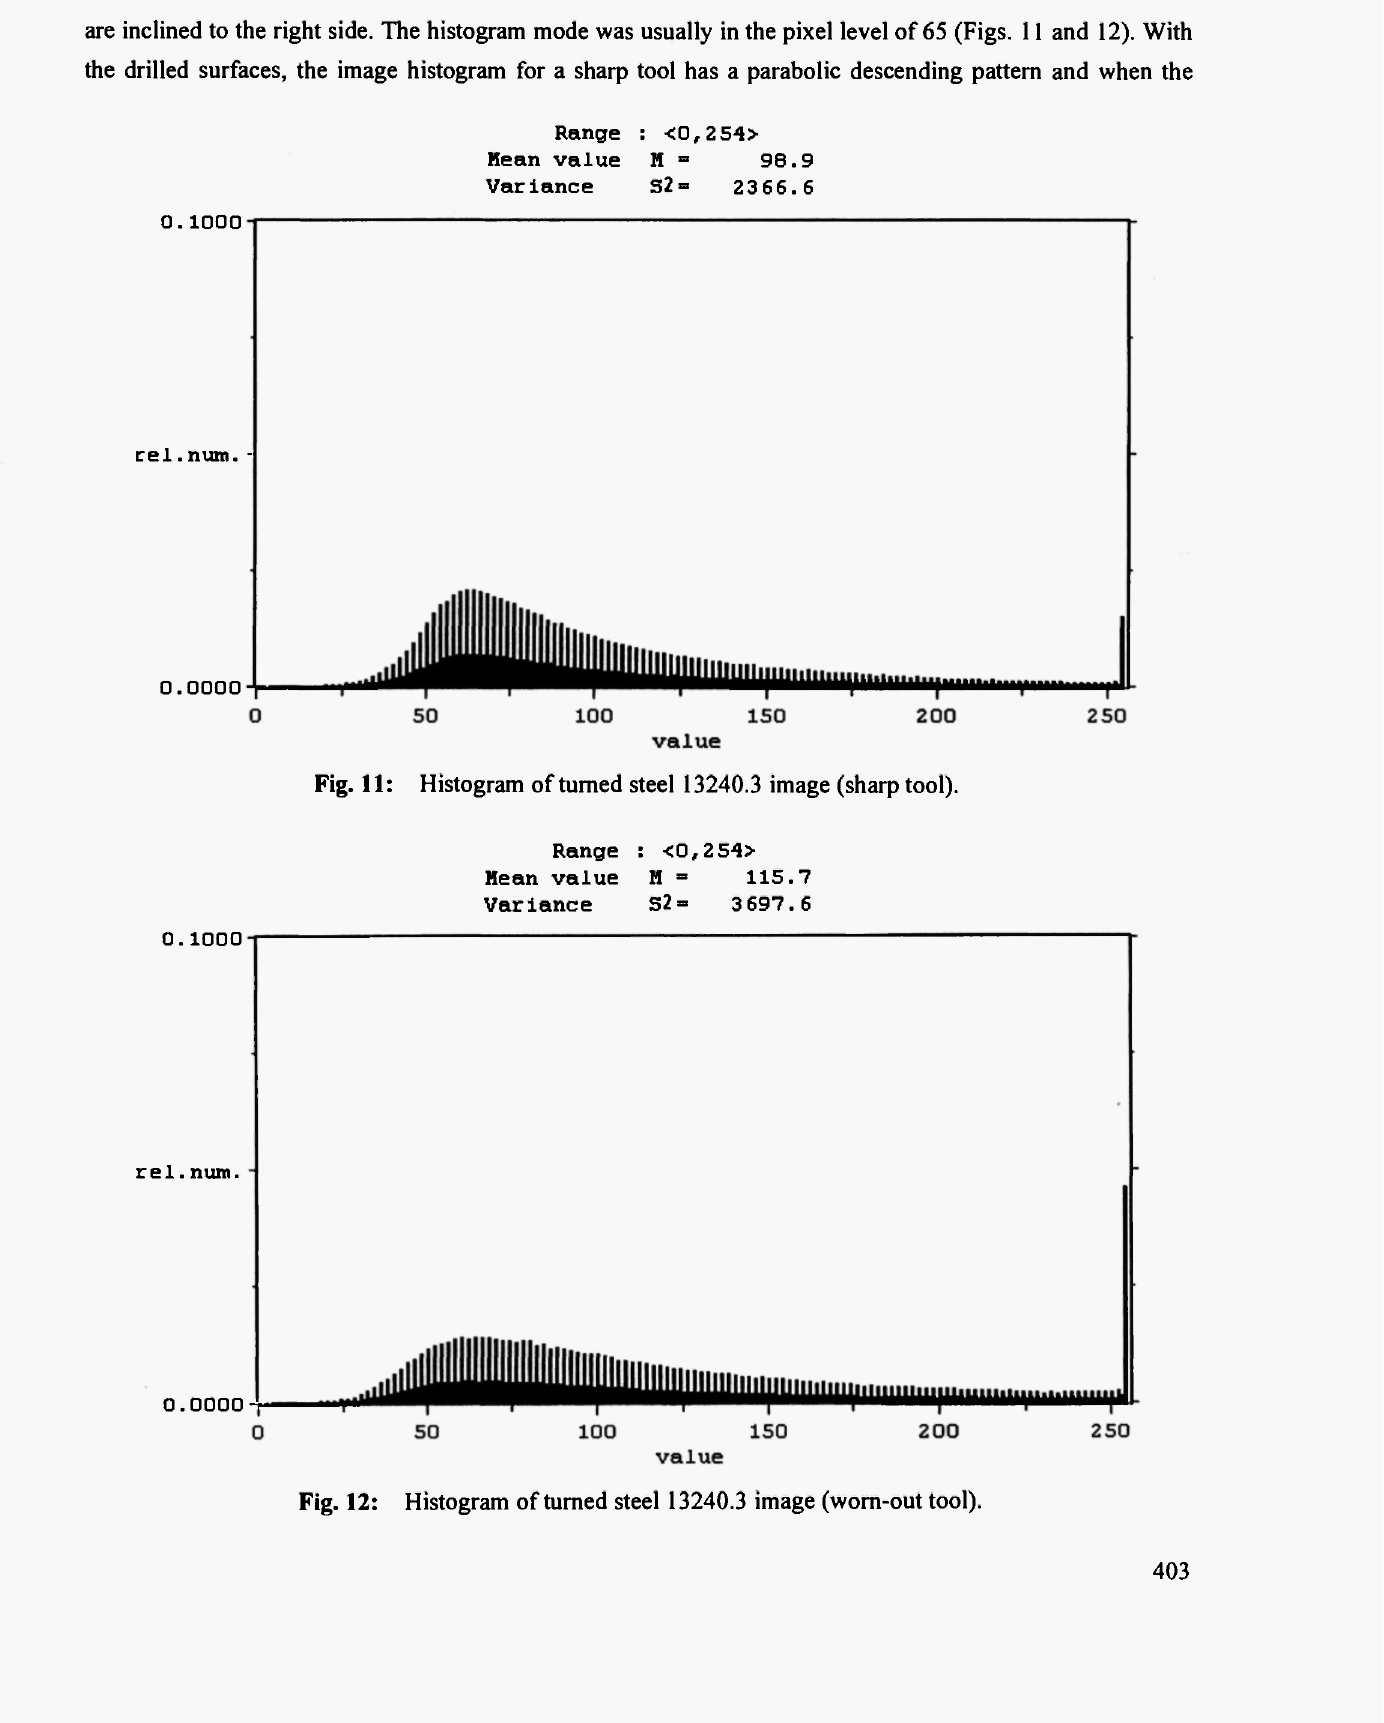
Fig. 11: Histogram of turned steel 13240.3 image (sharp tool).